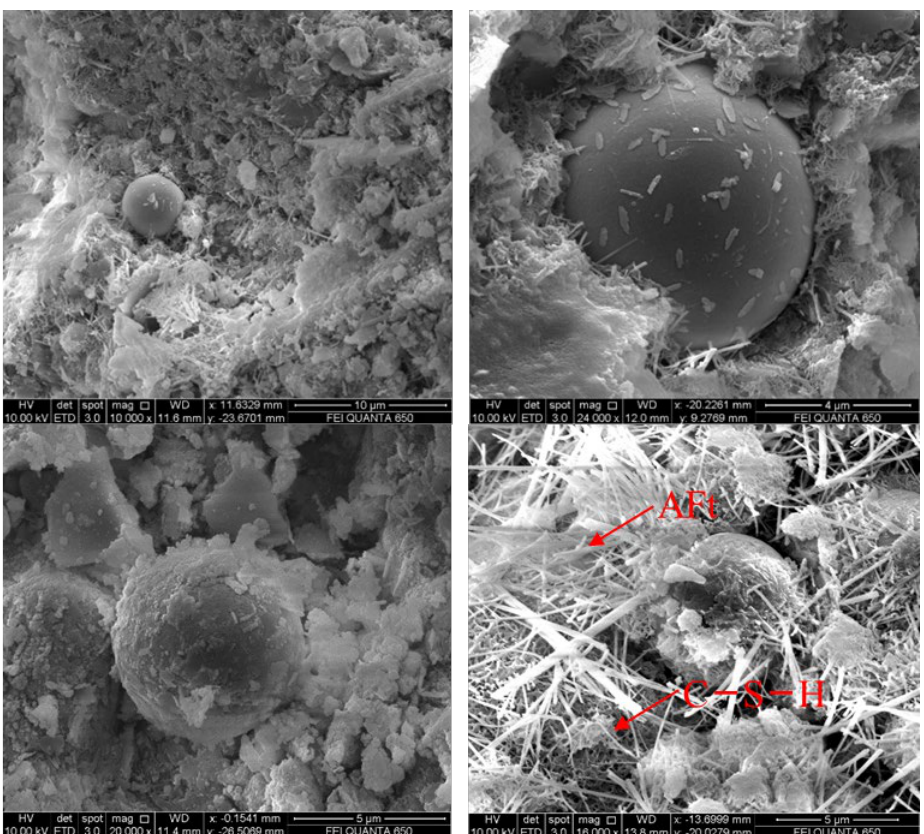
Figure 12. Micromorphology of fly-ash-modified CSM with 100% RMA at different ages (CF1 group). (Note: the upper left is 3 d, the upper right is 7 d, the lower left is 14 d, the lower right is 28d).